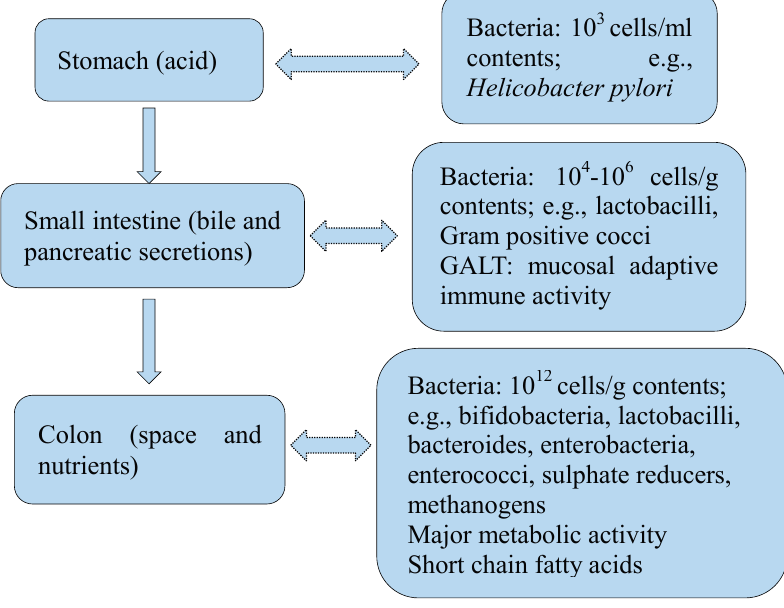
Figure 1. Reciprocal relationship between human gut bacteria and the